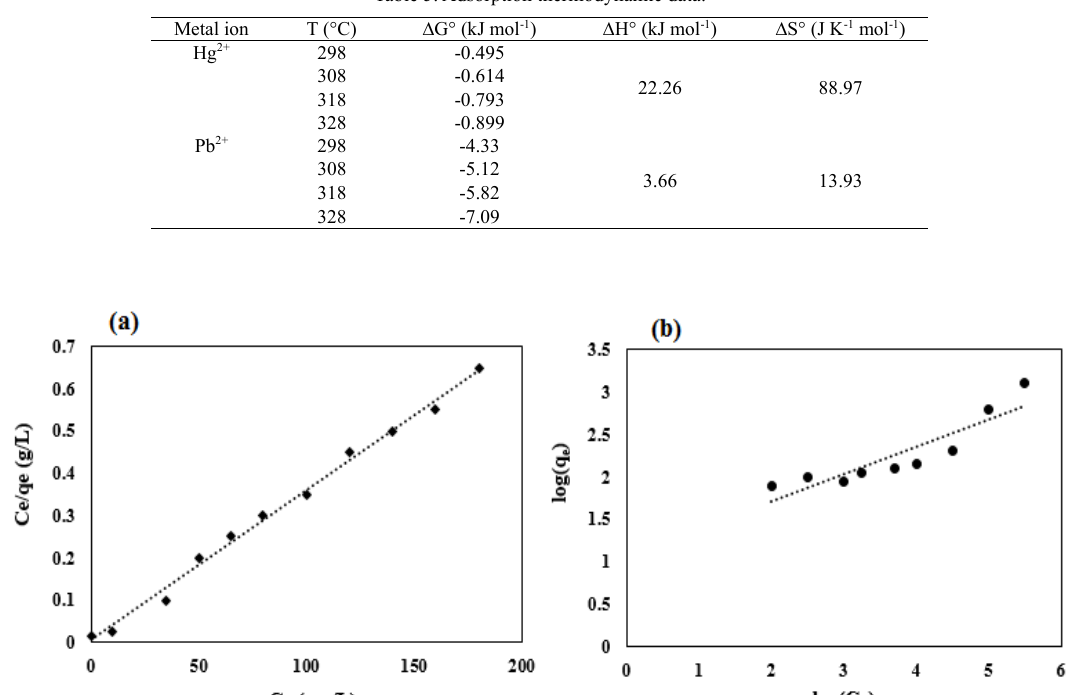
Fig. 8. (a) Langmuir isotherms for Pb 2+ adsorption onto NiO/ZSM-5. (b) Freundlich isotherms for Pb 2+ adsorption onto NiO/ZSM-5.